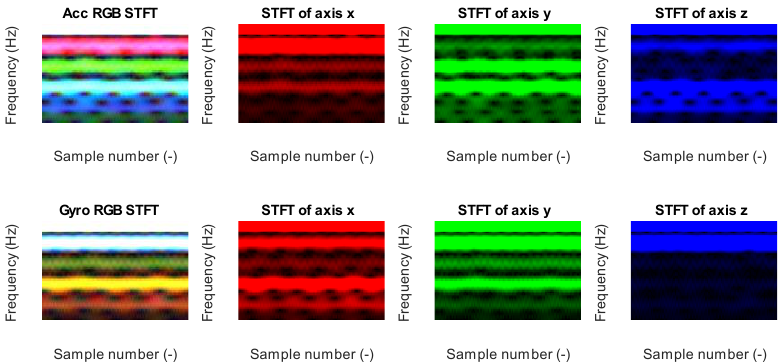
Figure 19. STFT RGB image of the fault class for the accelerometer x , y , and the z axis ( top ) and gyroscope x , y , and z ( bottom ).